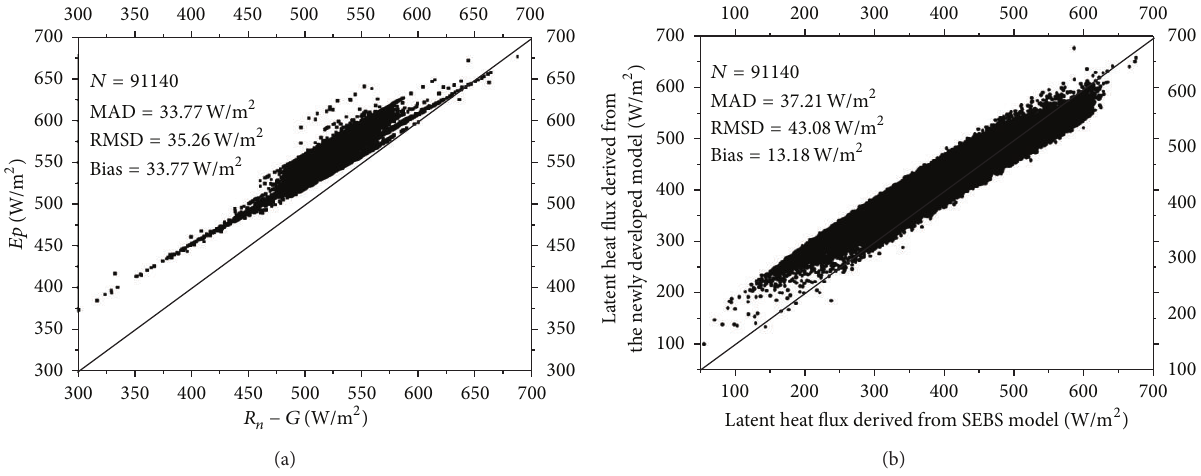
Figure 8: An intercomparison of the SEBS model and the newly developed model. (a) Comparison of the forcing energy (W/m 2 ) used in SEBS and the newly developed model. (b) Comparison of the latent heat flux (W/m 2 ) estimates from SEBS and the newly developed model.